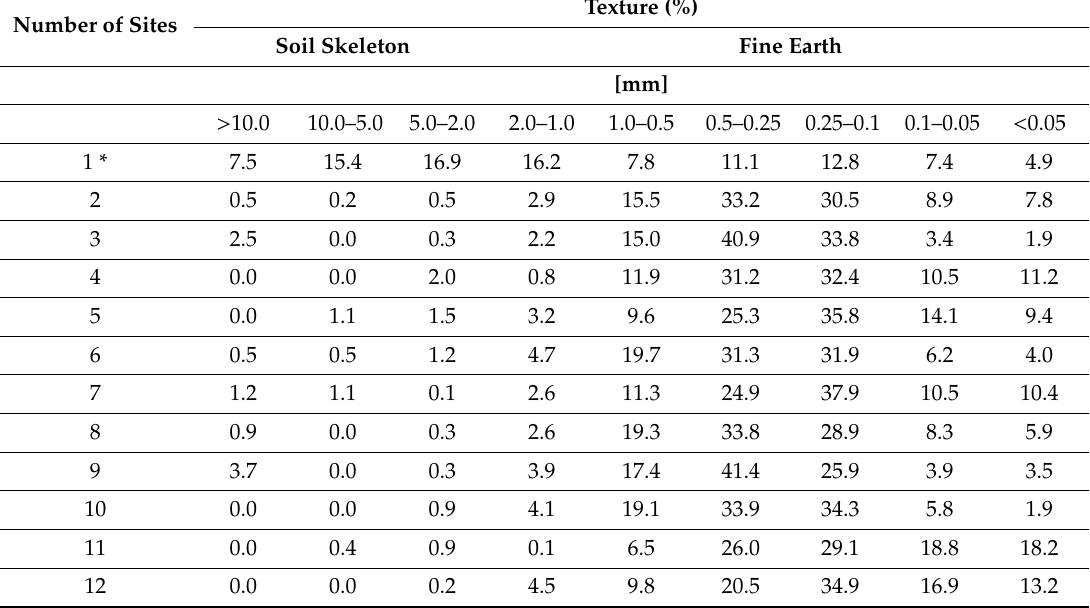
* Arabic numeral corresponds to the number of sites and name of the vegetation community as in Table